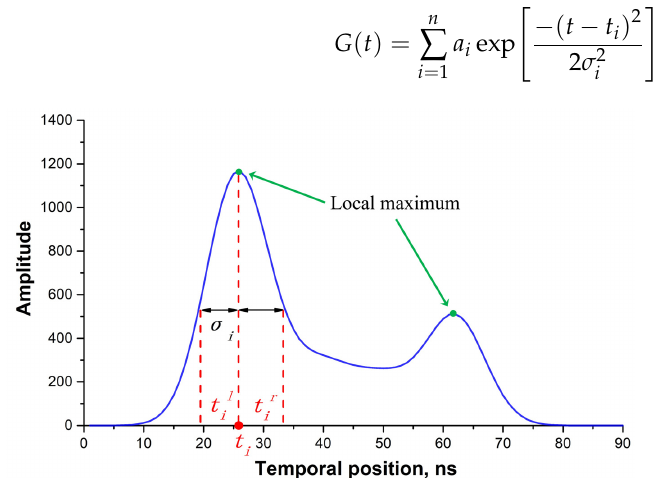
Figure 4. Diagram of the minimum half-wavelength in waveform data. The blue curve represents the signal segment after noise filtering; the red dashed lines denote the temporal position of the peak and half-peak amplitude.